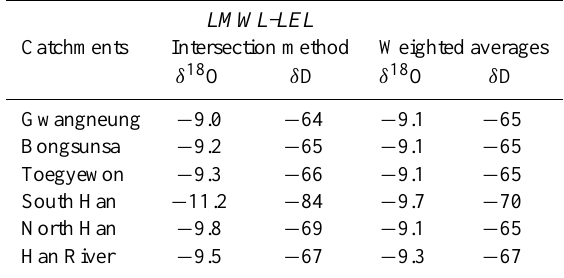
Table 3. The mean isotope composition of precipitation in the stud- ied catchments derived from two different methods for the period from 2005 to 2006. LMWL-LEL Catchments Intersection method Weighted averages